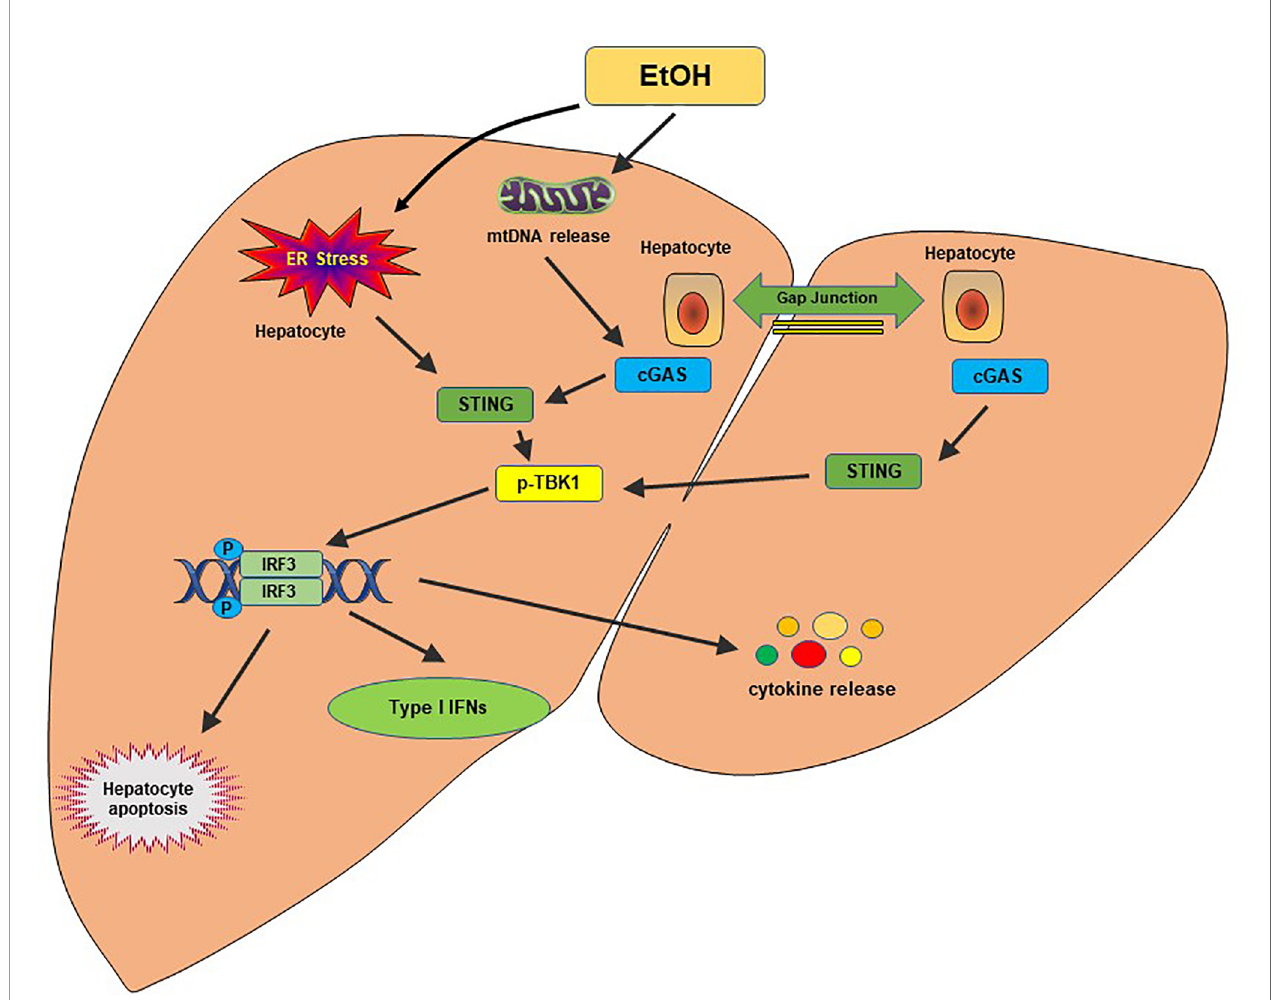
FIGURE 3 | The cGAS-STING pathway in alcohol-related liver disease. Alcohol-induced ER stress and mtDNA release activate the STING pathway. STING facilitates IRF3 phosphorylation by TBK1, which results in the translocation of IRF3 into the nucleus, where it induces transcription of type I IFNs. A gap junction intracellular communication pathway between alcohol-exposed hepatocytes and the neighboring parenchyma also contributes to the IRF3 activation by cGAS. Activation of IRF3 could trigger hepatocyte apoptosis, type I IFN response and produce proin fl ammatory cytokines, leading to hepatic in fl ammation and